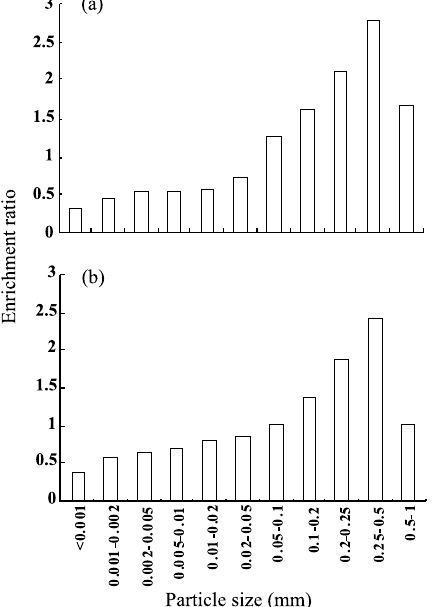
Figure 4. The enrichment ratio of various particle- size groups in detailed classes in the two deposited farmland soils; (a) filled deposited farmland soil; (b) silting deposited farmland